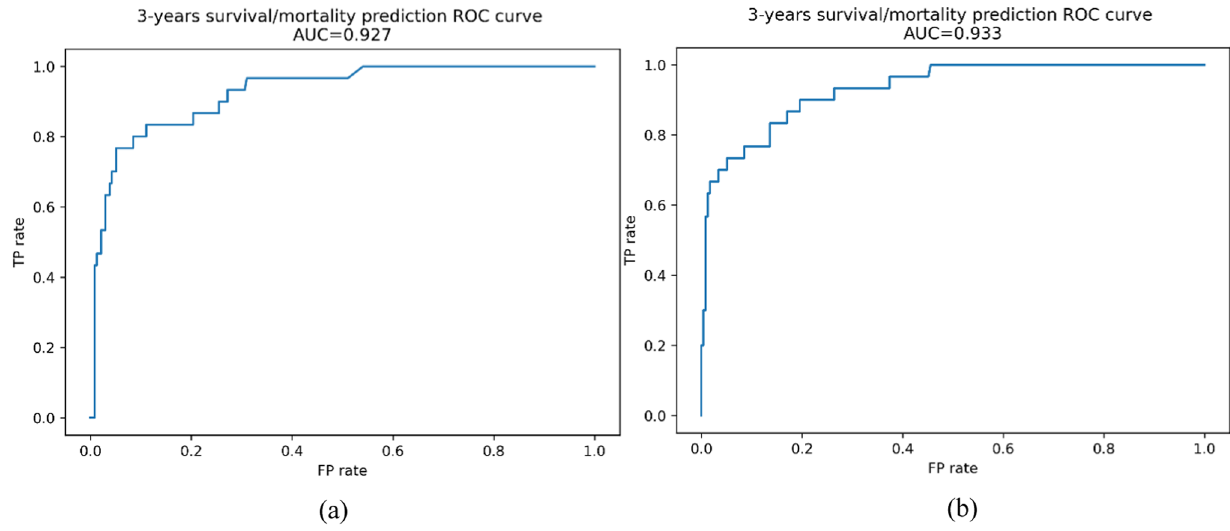
Fig. 4 Best prognostic models ROC curves and AUC values, a RF, b